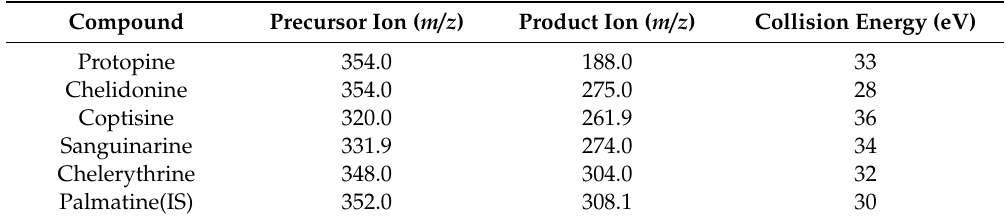
Table 6. MRM ion transitions and collision energies used for the determination of five alkaloids and IS. Compound Precursor Ion ( m / z ) Product Ion ( m / z ) Collision Energy (eV) Protopine 354.0 188.0 33 Chelidonine 354.0 275.0 Coptisine 320.0 261.9 Sanguinarine 331.9 274.0 Chelerythrine 348.0